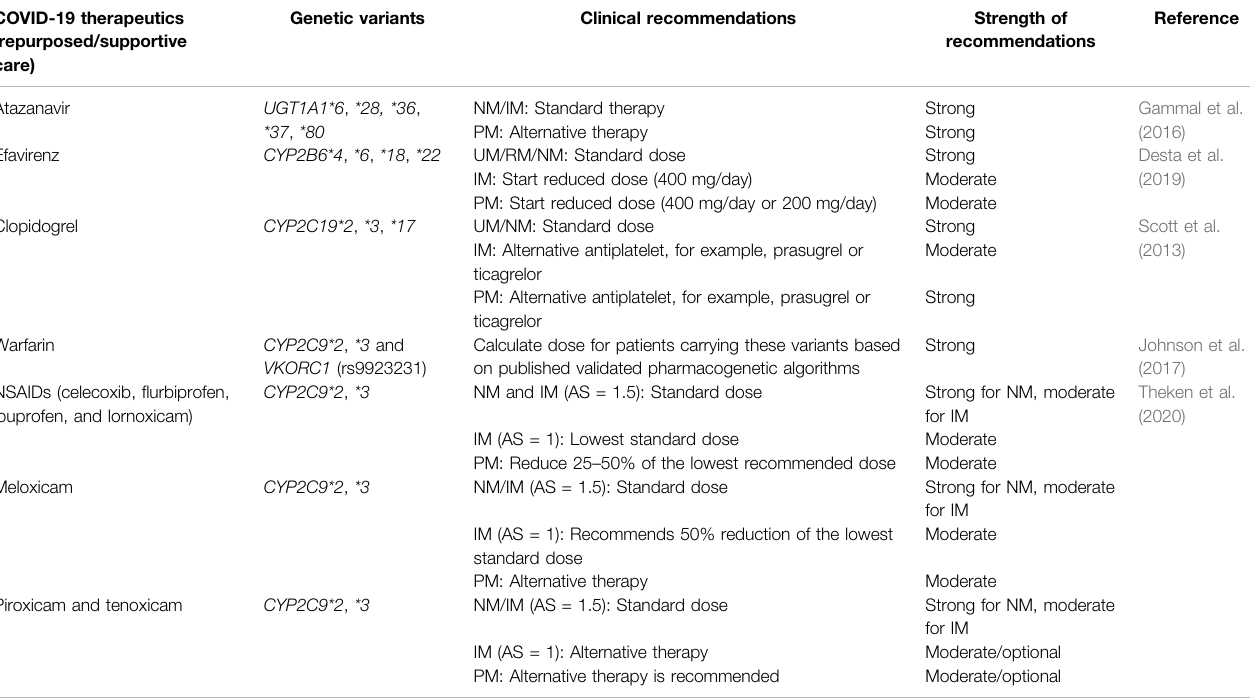
TABLE 11 | CPIC pharmacogenomic-based dosing guidelines for drug using in COVID-19. COVID-19 therapeutics (repurposed/supportive